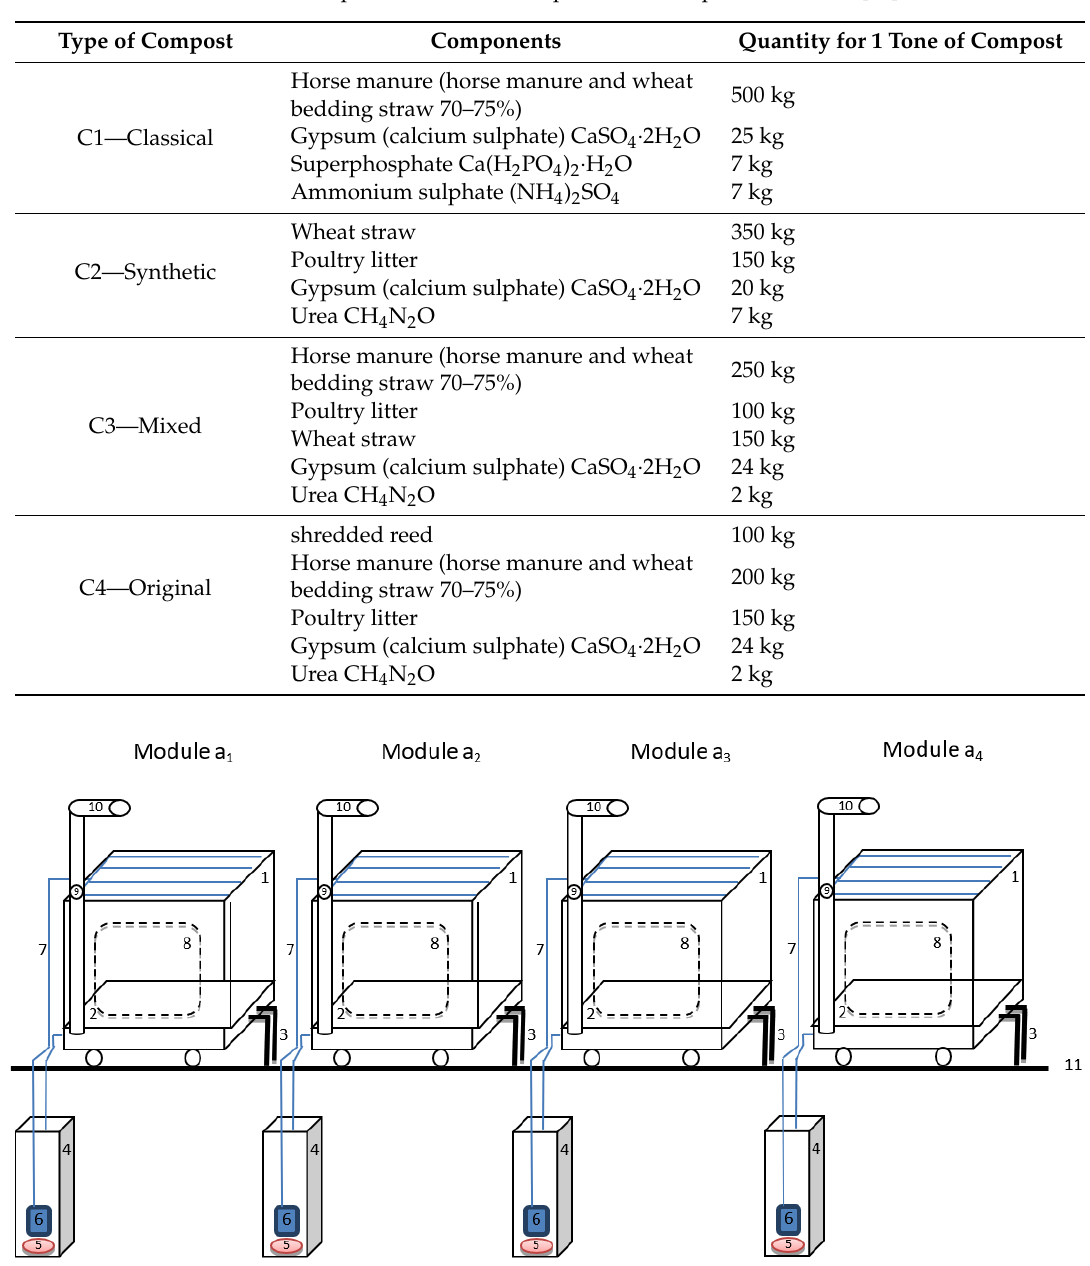
Table A2. Recipes for substrate / compost used in experimental trial [68].